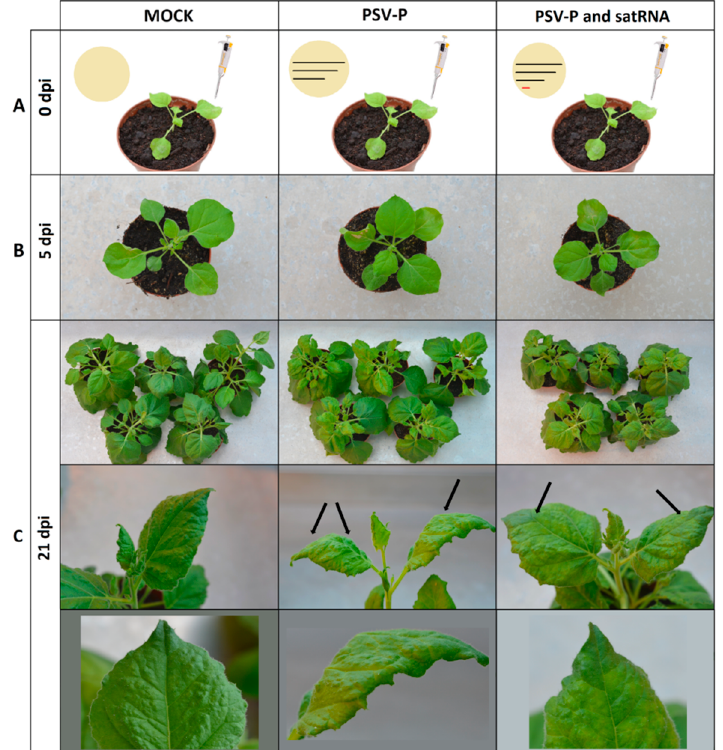
Figure 1. Schematic representation of the infection strategies and resulting phenotypes. ( A ) N. benthamiana plants inoculated with inoculation buffer (MOCK), inoculation buffer supplied with in vitro transcripts of peanut stunt virus (PSV)-P genomic strands (black lines) (PSV-P), inoculation buffer supplied with in vitro transcripts of PSV-P genomic strands and satellite RNA (black lines and red line, respectively) (PSV-P and satRNA) ( A ). ( B , C ) N. benthamiana plants inoculated with the following: inoculation buffer (MOCK), in vitro transcribed PSV-P genomic strands (PSV-P), and in vitro transcribed PSV-P genomic strands and satellite RNA (PSV-P and satRNA) at 5 days post inoculation (dpi) ( B ) and 21 dpi ( C ). Black arrows indicate infection symptoms: chlorosis and leaf malformations generated by PSV-P and chlorosis in PSV-P and satRNA-treated plants ( C ).